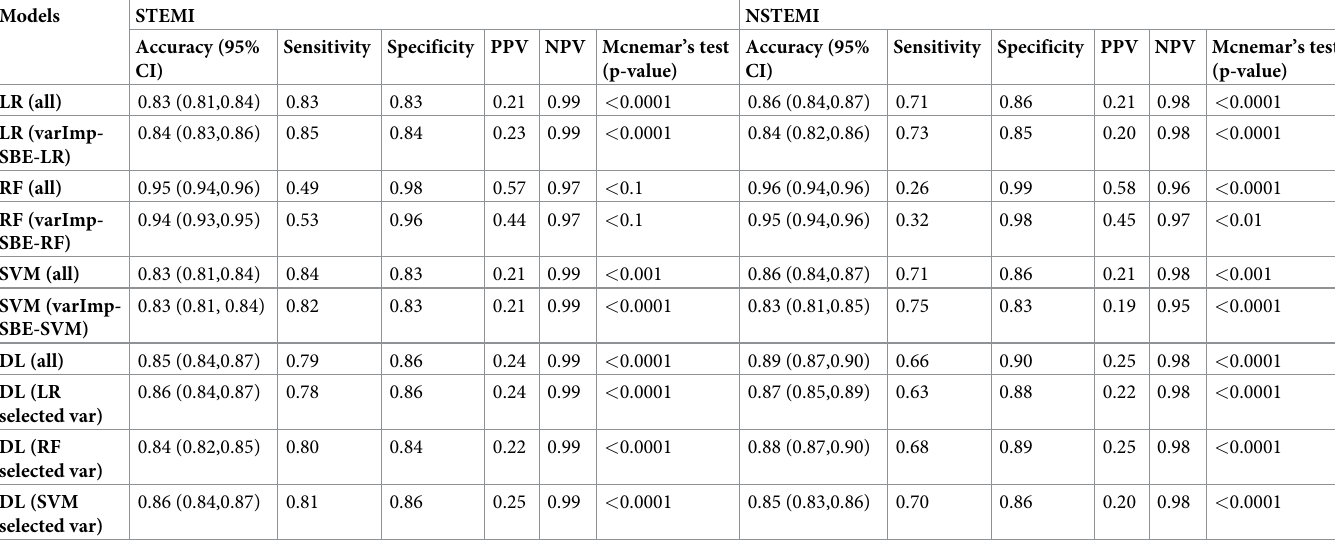
Table 5. Detailed performance metrics of DL and ML with and without feature selection for STEMI and NSTEMI patients. Models